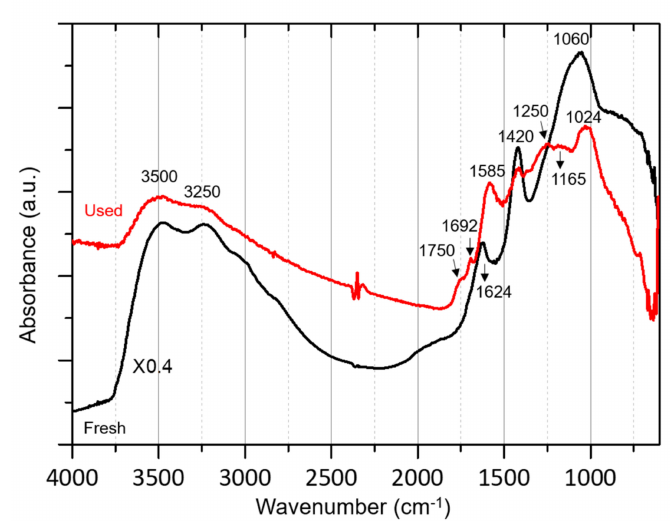
Figure 4. Di ff use Reflectance Infrared Fourier Transform (DRIFT) spectra of fresh (before the reaction) and used (after the reaction) hydrated catalysts at room temperature.